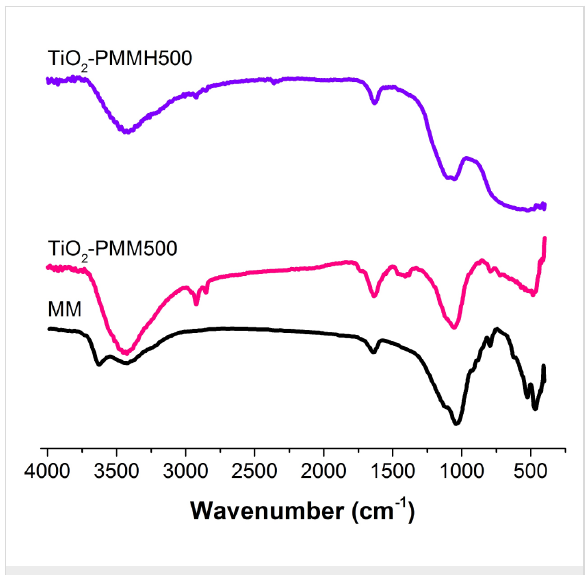
Figure 3: FTIR spectra of the raw MM, and TiO 2 -pillared MM.